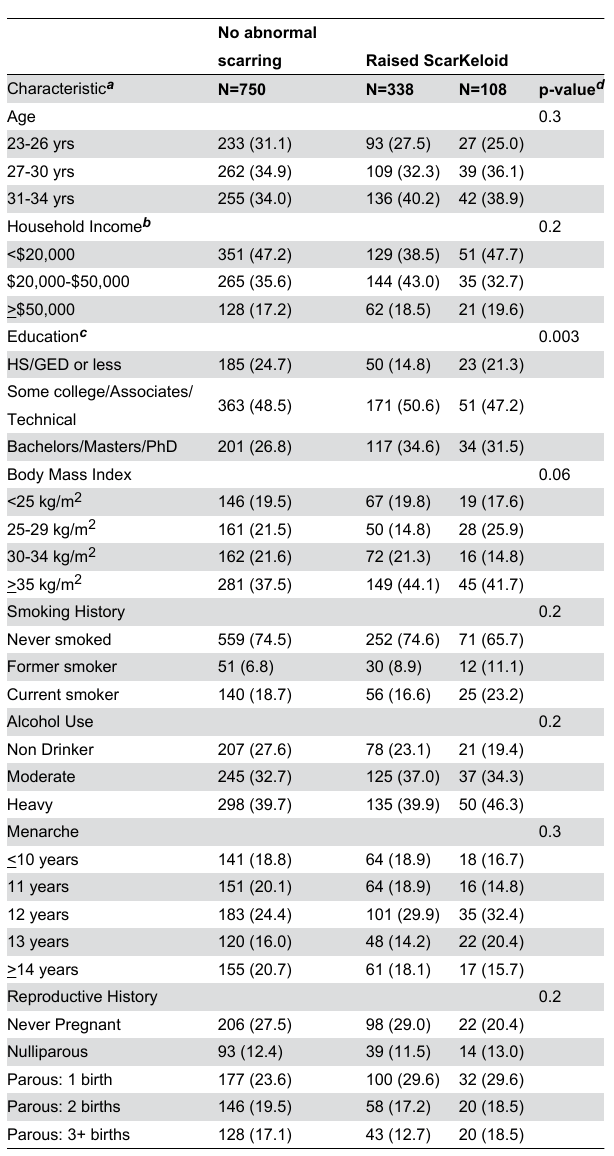
Table 2. Association [Risk Ratio (95% Confidence Interval) p-value] Between Self-Reported Scars and Prevalent Fibroids.